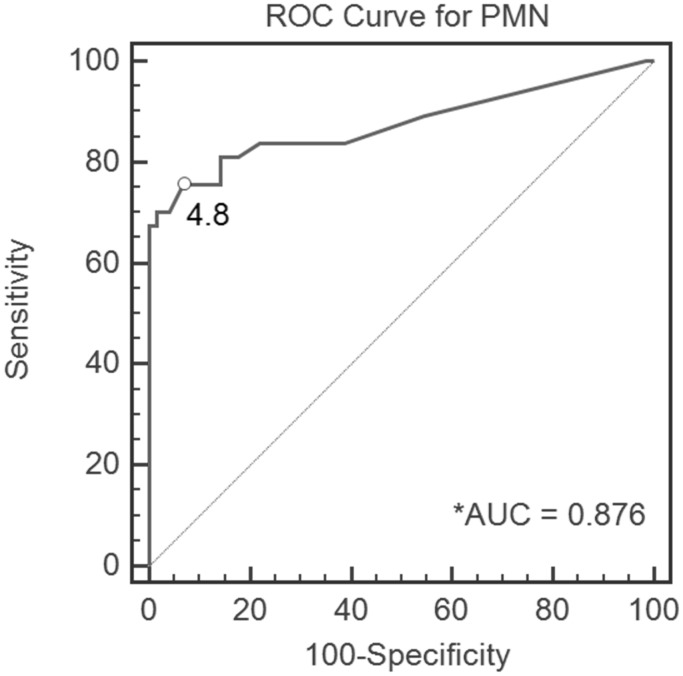
Receiver operating characteristic (ROC) curve, demonstrating the polymorphonuclear leukocyte number (PMN) cutoff value of 2.4 for all patients in the cohort.*AUC, area under the curve.